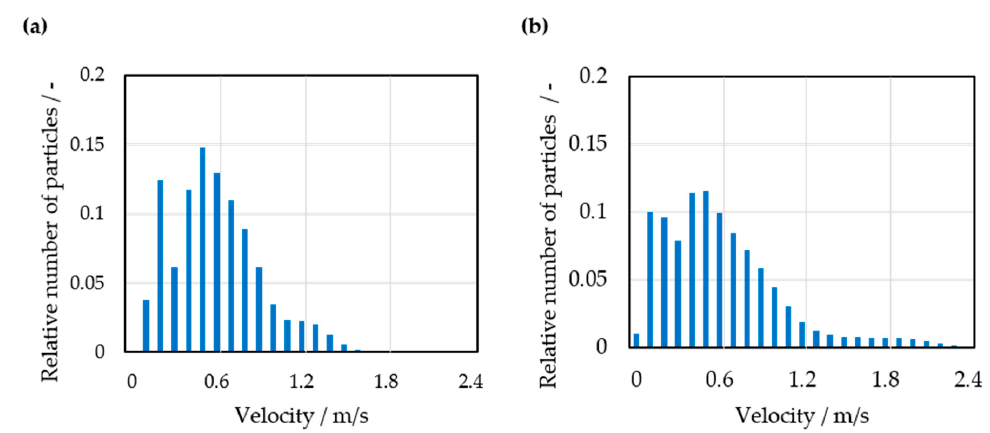
Figure 11. Velocity distribution of the particles for the double water injection (case III) ( a ) and for the injection with the Pharmacoat 606 solution (case IV) ( b ).